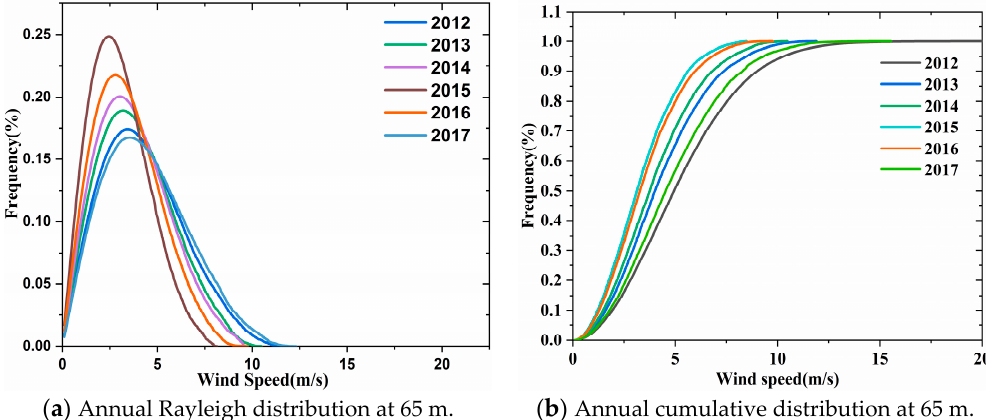
Figure 5. Annual ( a ) Weibull and ( b ) cumulative distribution from 2012 to 2017 at 65 m hub height. Energies 2019 , 12 , x FOR PEER REVIEW